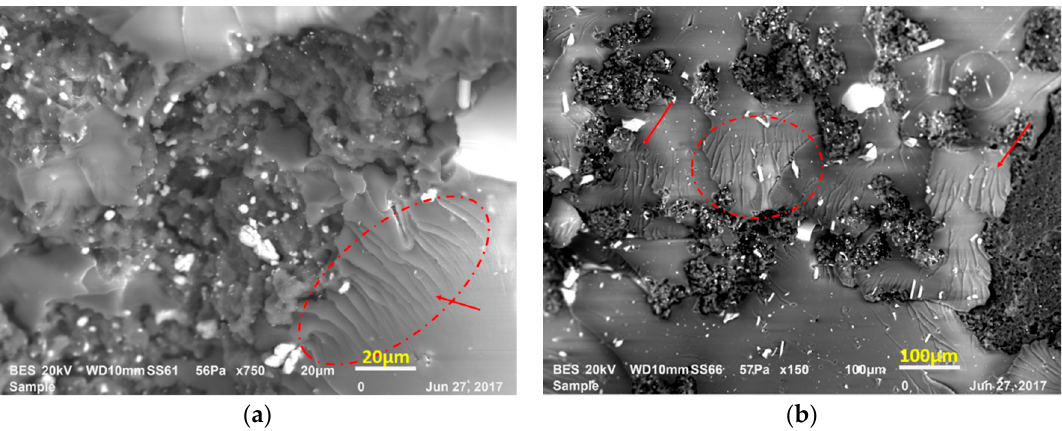
Figure 11. Shear yielding in LRAL composites. ( a ) LR2AL5 group, ( b ) LR2AL7.5 group.